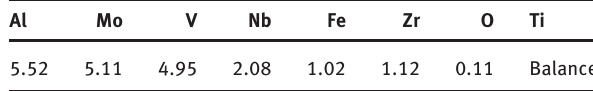
Table 1: Chemical composition (in wt.%) of Ti555211 titanium alloy.